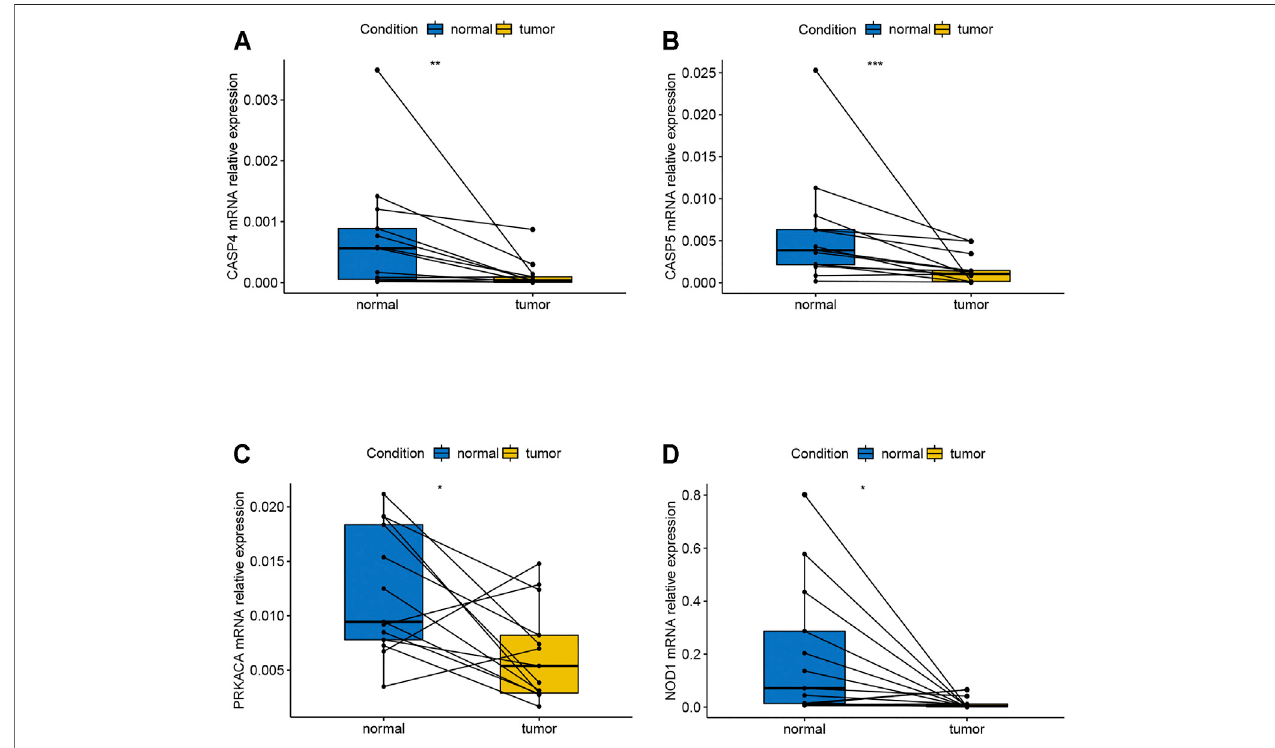
FIGURE8| mRNArelativeexpressionofgenesintheriskmodelbythemethodofqPCR. (A) mRNArelativeexpressionofCASP4; (B) mRNArelativeexpressionof CASP5; (C) mRNA relative expression of PRCAKA; (D) mRNA relative expression of NOD1. qPCR, quantitative real-time polymerase chain reaction.